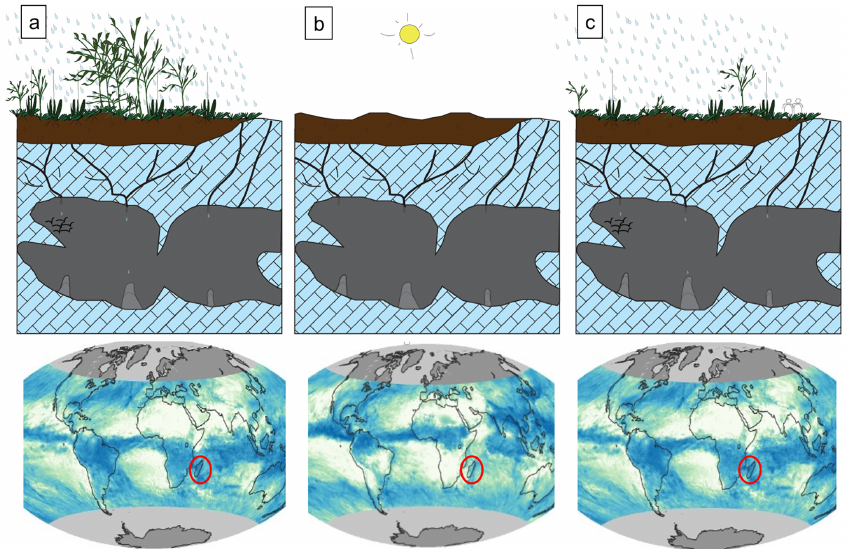
Figure 7. Simplified models portraying Holocene climate change in NW Madagascar and the possible climatic conditions linked to the ITCZ. (a) Wetter conditions during the early Holocene with the ITCZ further south (prior to ca. 7.8kaBP), favorable for stalagmite deposition. (b) Periodic dry conditions during the mid-Holocene (between ca. 7.8 and 1.6kaBP) with the ITCZ further north leading to no stalagmite formation (refer to Sect. 5.2.2). (c) Wetter conditions during the late Holocene (after ca. 1.6kaBP) with the ITCZ further south, favorable for stalagmite deposition. Drawings are not to scale. The bottom figures are from the same source as Fig. 1a, and they are only used here to give a perspective of the possible position of the ITCZ during the early, mid, and late Holocene. Madagascar is indicated with a red